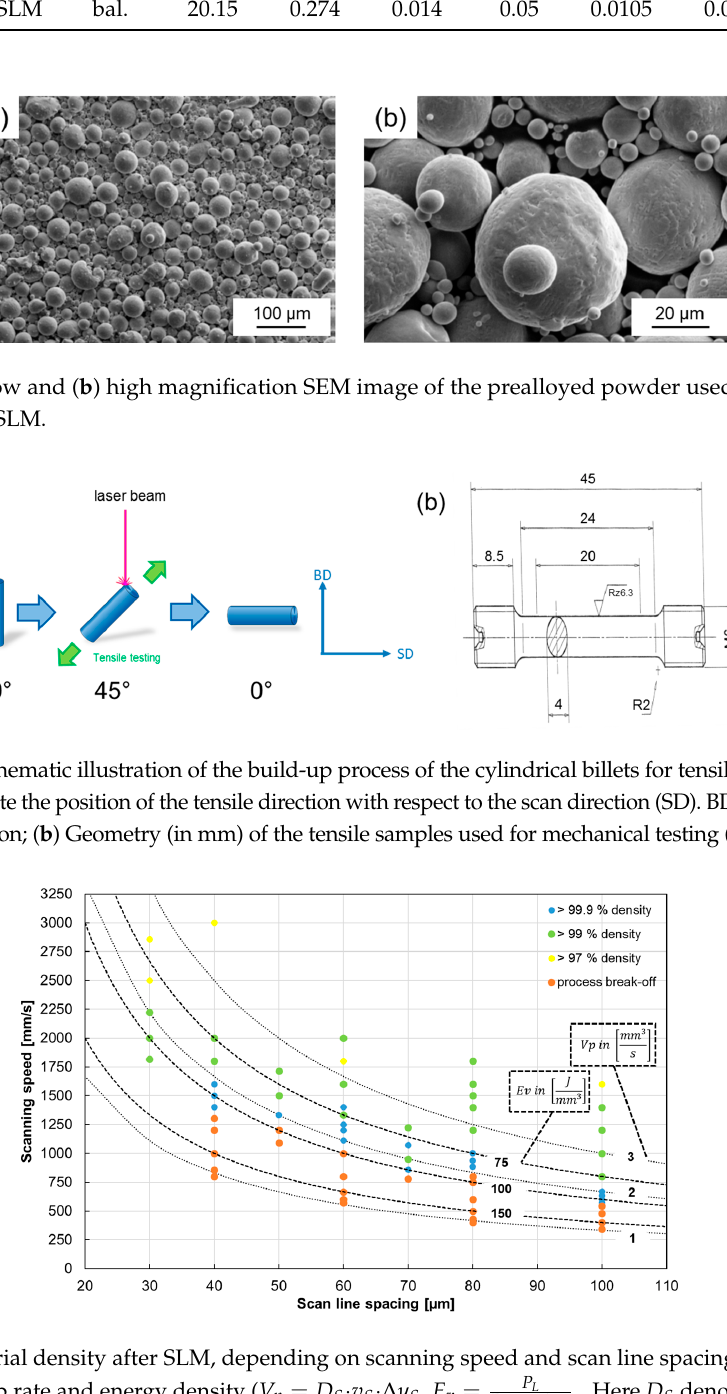
Figure 3. Material density after SLM, depending on scanning speed and scan line spacing. V P and E V denote build-up rate and energy density ( V p = D S · v S · ∆ y S , E v = P L layer thickness, v S the scan speed, Δ y S the scan line spacing, and P L the laser power), respectively.